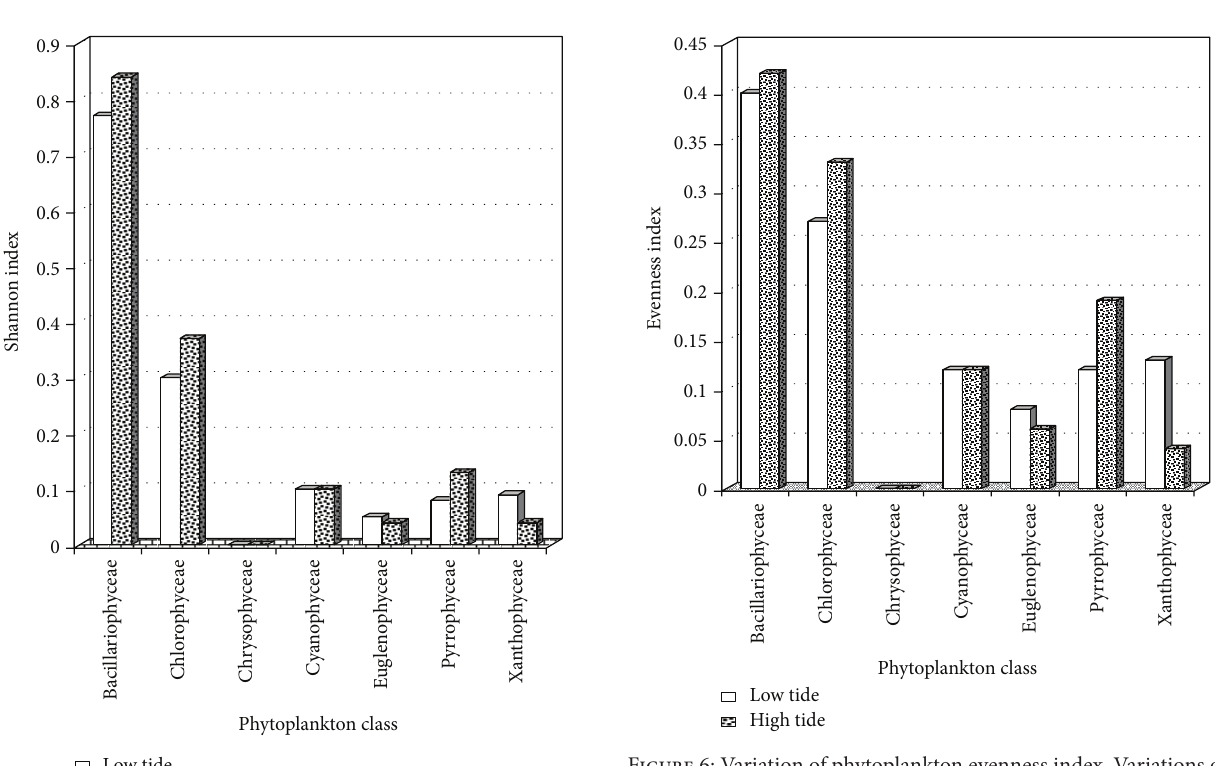
Figure 6: Variation of phytoplankton evenness index. Variations of phytoplankton parameters in relation to tide in Okpoka